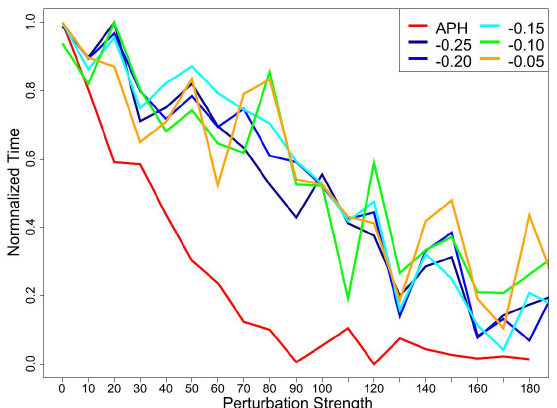
Figure 4. Normalized Arrival times for anti-pheromone (APH) and perturbed Markov model with different σ strength.